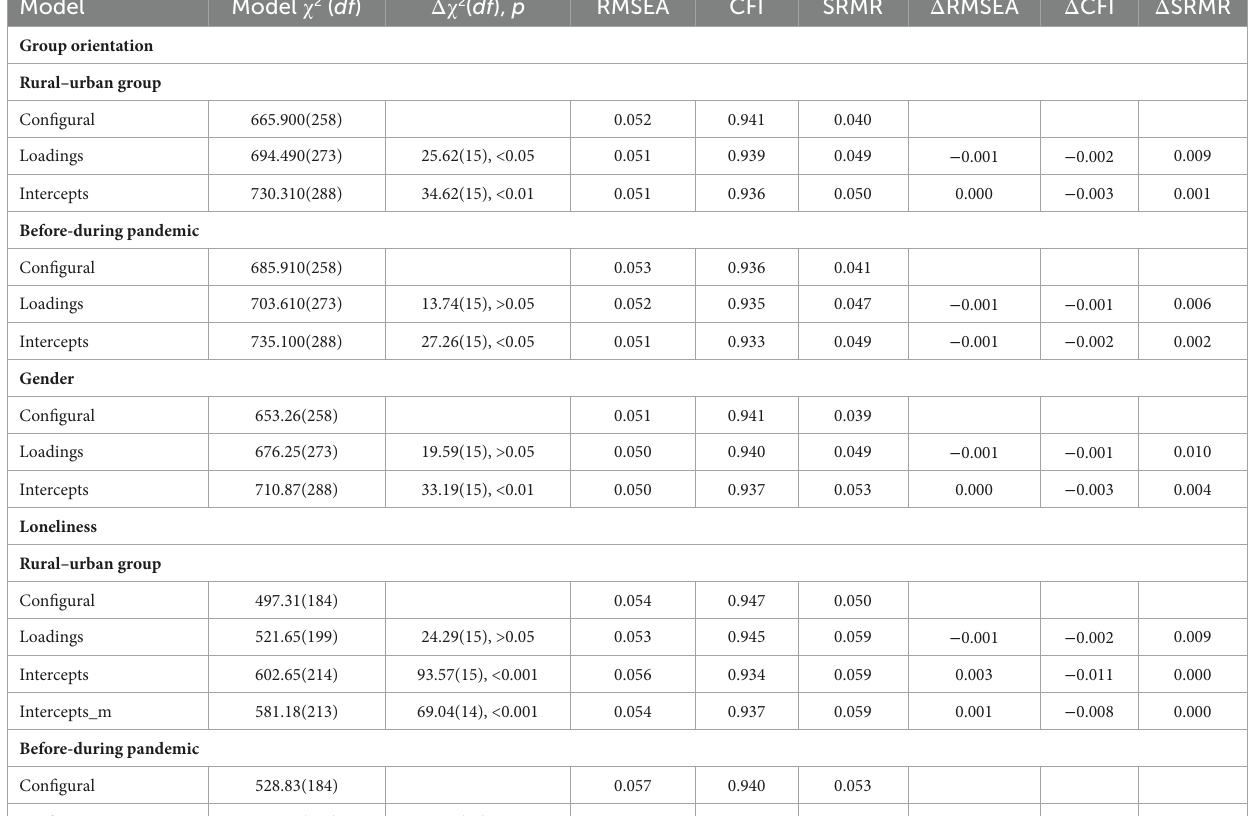
TABLE 2 Fit statistics for measurement model and tests of measurement invariance.